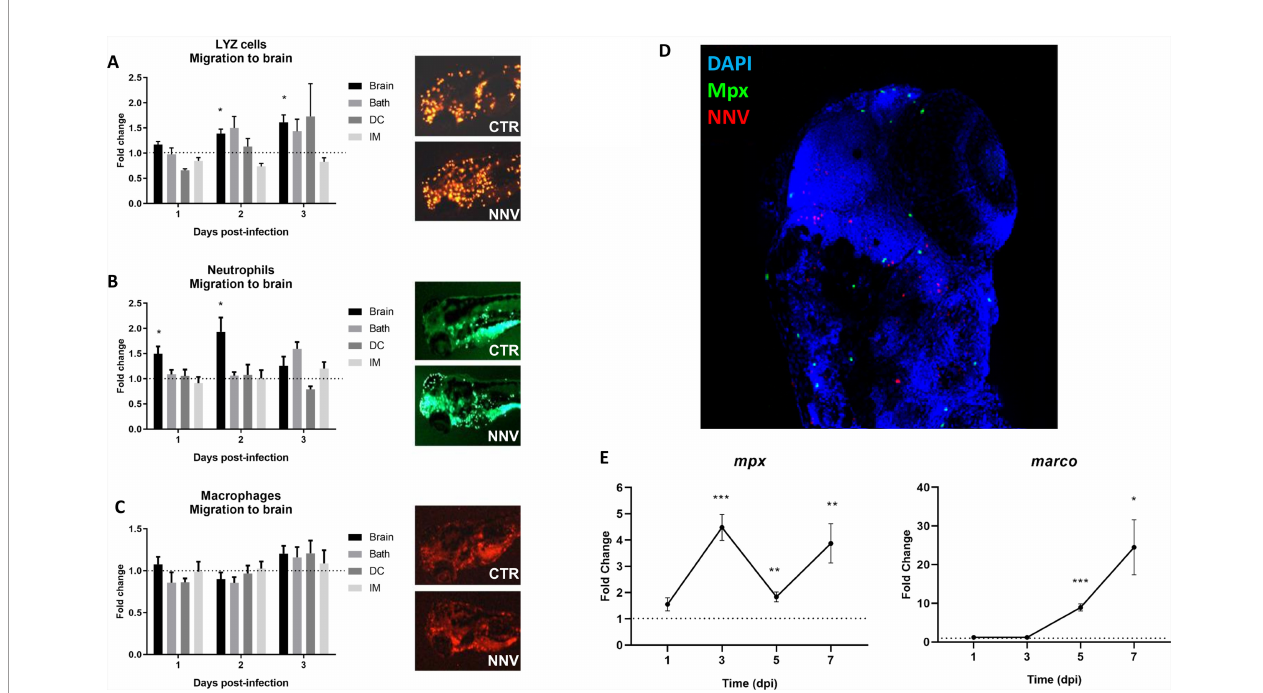
FIGURE 4 | Visualization and analysis of innate immune cell migration to the head of 3 pdf larvae infected through different routes. The transgenic zebra fi sh lines (A) Tg( lyz :DsRed2), (B) Tg( mpx :GFP) and (C) Tg( mpeg :mCherry) were used to analyse the migration of myeloid precursors with lysozyme activity, neutrophils and macrophages, respectively, to the cephalic region. Larvae were infected through the 4 infection routes analysed in this study, and the cells were counted at 1, 2 and 3 dpi. Fluorescent immune cells were counted using ImageJ, and the graphs represent the difference in fold change of the number of cells located in the head from infected larvae compared to their corresponding uninfected control larvae (control FC = 1 in the dotted line). Representative images of the three transgenic lines at 2 dpi were included. (D) Whole-mount immuno fl uorescence of Tg( mpx :GFP) transgenic larvae infected via the brain with NNV at 1 dpi; neutrophils are displayed in green, NNV are displayed in red, and nuclei are displayed in blue. No colocalization between NNV particles and neutrophils was observed. (E) Expression analysis of marker genes of the two major innate immune cells ( mpx – neutrophils, marco – macrophages) in NNV-infected and uninfected larvae at different times postinfection. Each sample (5 biological replicates, pools of 4 larvae each) was normalized to the 18S gene. The normalized expression values were standardized against their respective controls (Control FC = 1, dotted lines). For (A – C, E) , the graphs represent the mean ± SEM of the biological replicates. Statistically signi fi cant differences are displayed as follows: ***, 0.0001 > p value > 0.001; **, 0.001 > p value > 0.01; *, 0.01 > p value >